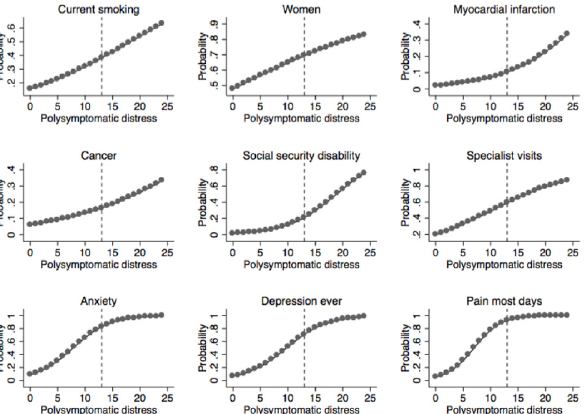
Fig 1. Predicted probabilities (unadjusted) of selected variables in the 2012 National Health Interview Survey as a function of polysymptomatic distress scores.